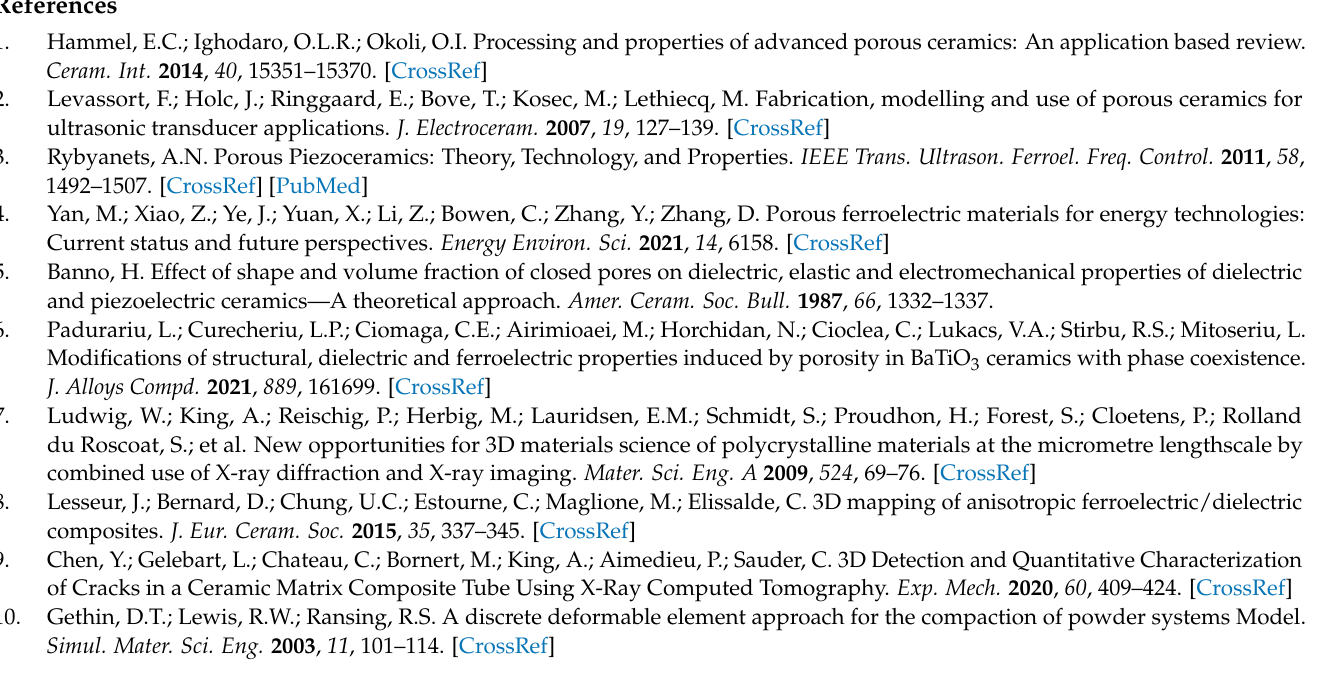
Figure S15: (a) Young’s modulus; (b) Deformed structure with von Mises stress plot, at step